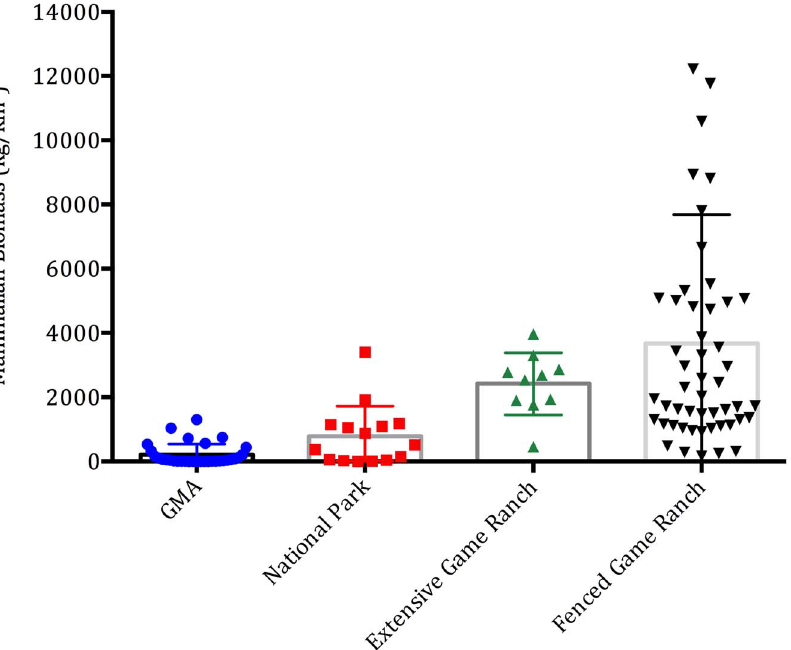
Figure 3. The biomass of wild ungulates (excluding species of bushbuck size and smaller and hippos, for which data were unavailable for state protected areas).